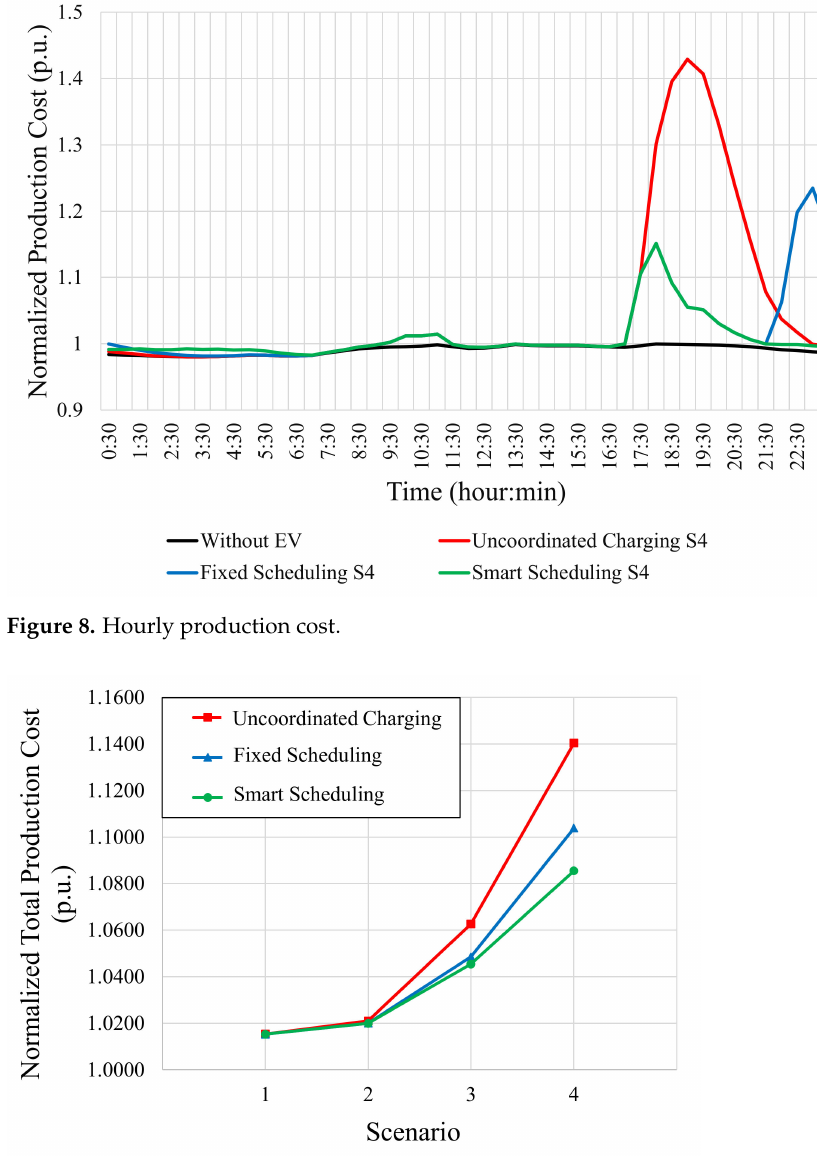
Figure 9. Daily total production cost